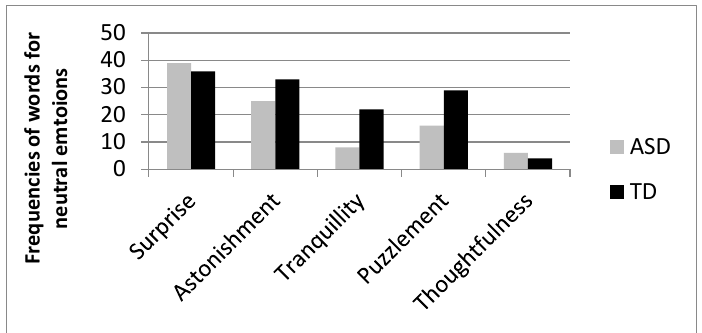
Figure 5. Frequency of use of terms corresponding to neutral emotions distinguished by ASD and TD participants.